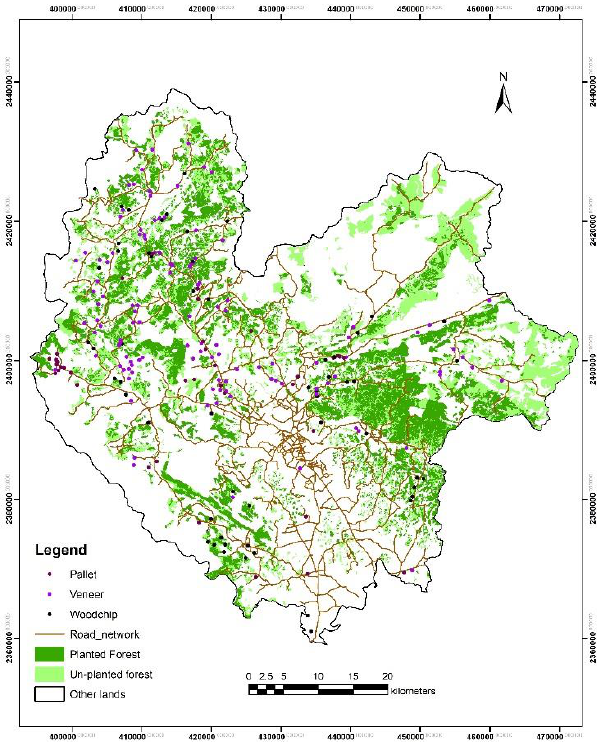
Figure 2. Map showing distribution of 215 wood processing mills and distribution of un- planted areas .